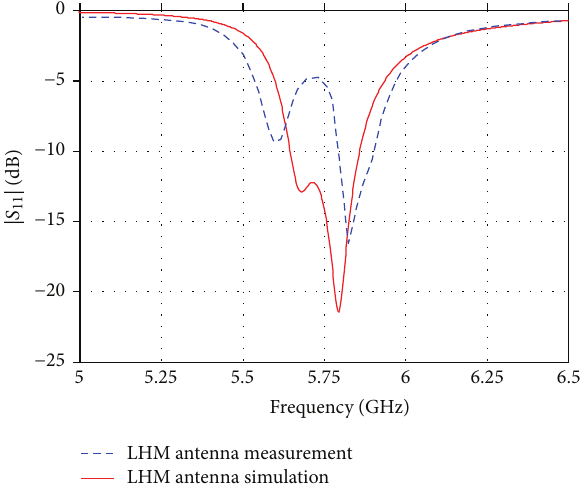
Figure 16: Reflection coefficients of FL-LHM antenna with ℎ = 30 mm in simulation and measurement.